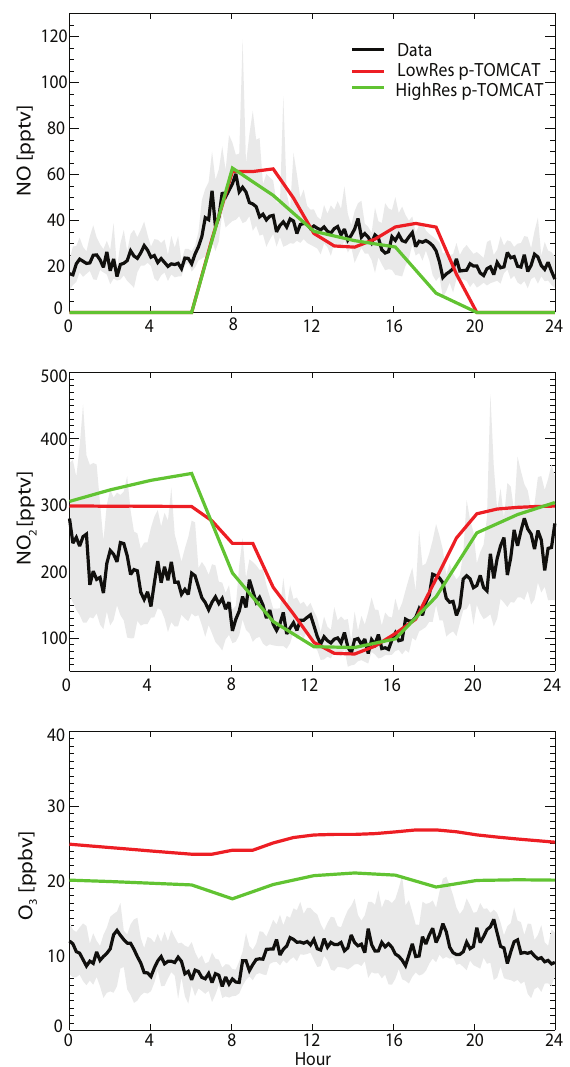
Fig. 3. Global model comparison to diurnal cycle of NO, NO 2 , and O 3 from the median diurnal cycle in the measurements (black, with 25–75 quartile in grey). The global model is shown in red (low resolution) and green (high resolution) for the lowest model level.